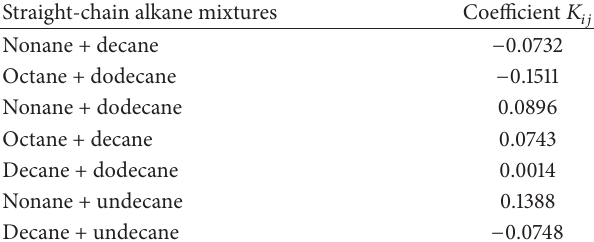
Table 4: The coefficient 𝐾 𝑖𝑗 .